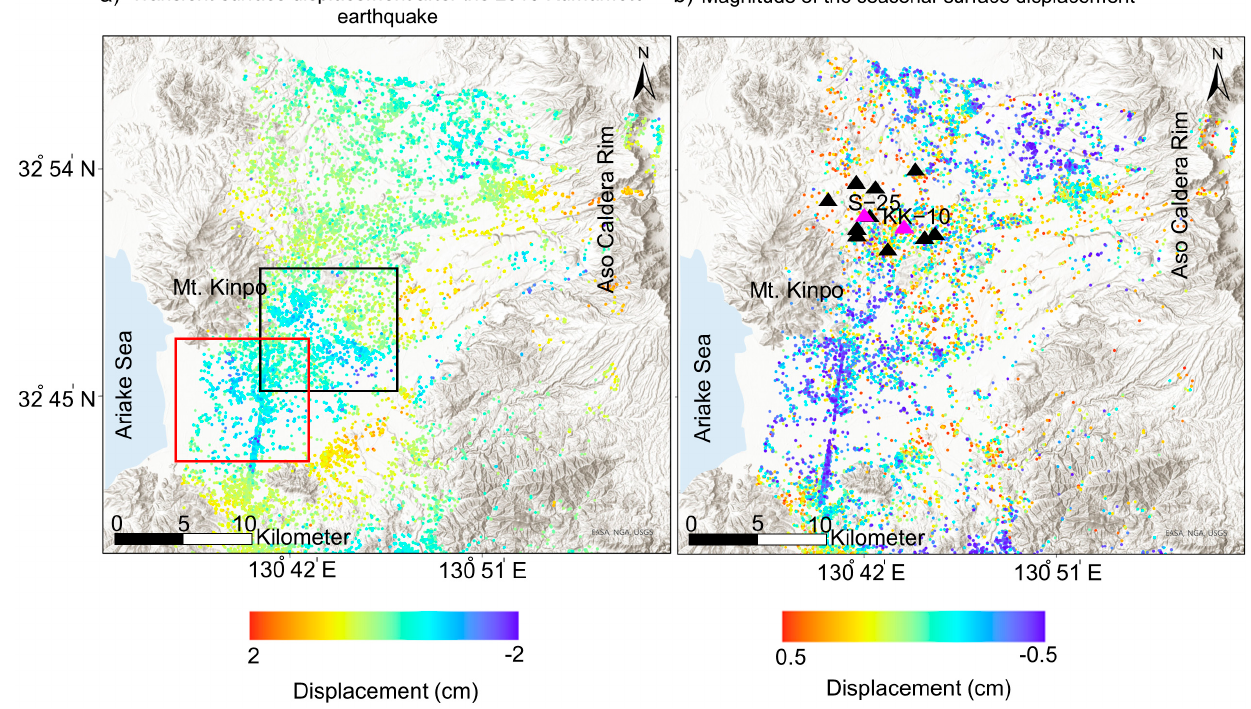
Figure 3. ( a ) Transient surface displacement map of the study area in the year posterior to the 2016 Kumamoto earthquake modified after [42]. ( b ) Seasonal surface displacement after the 2016 Kumamoto earthquake from PALSAR-2 images in a descending track mode modified after [42]. Triangles indicate groundwater well locations. Red triangles are KK − 10 and S − 25 sites displayed in Figure 5.